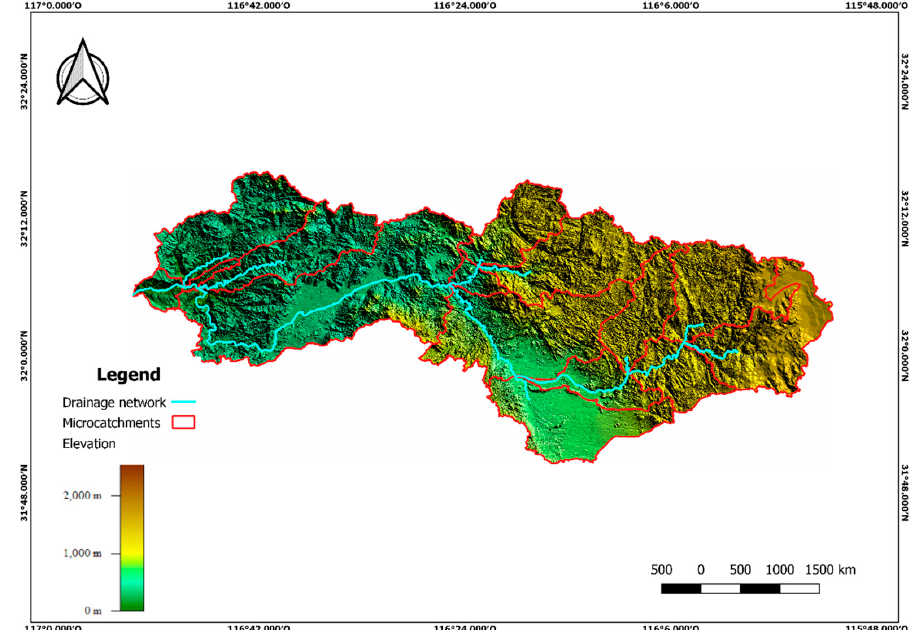
Figure 3. Digital elevation model for Guadalupe river basin.